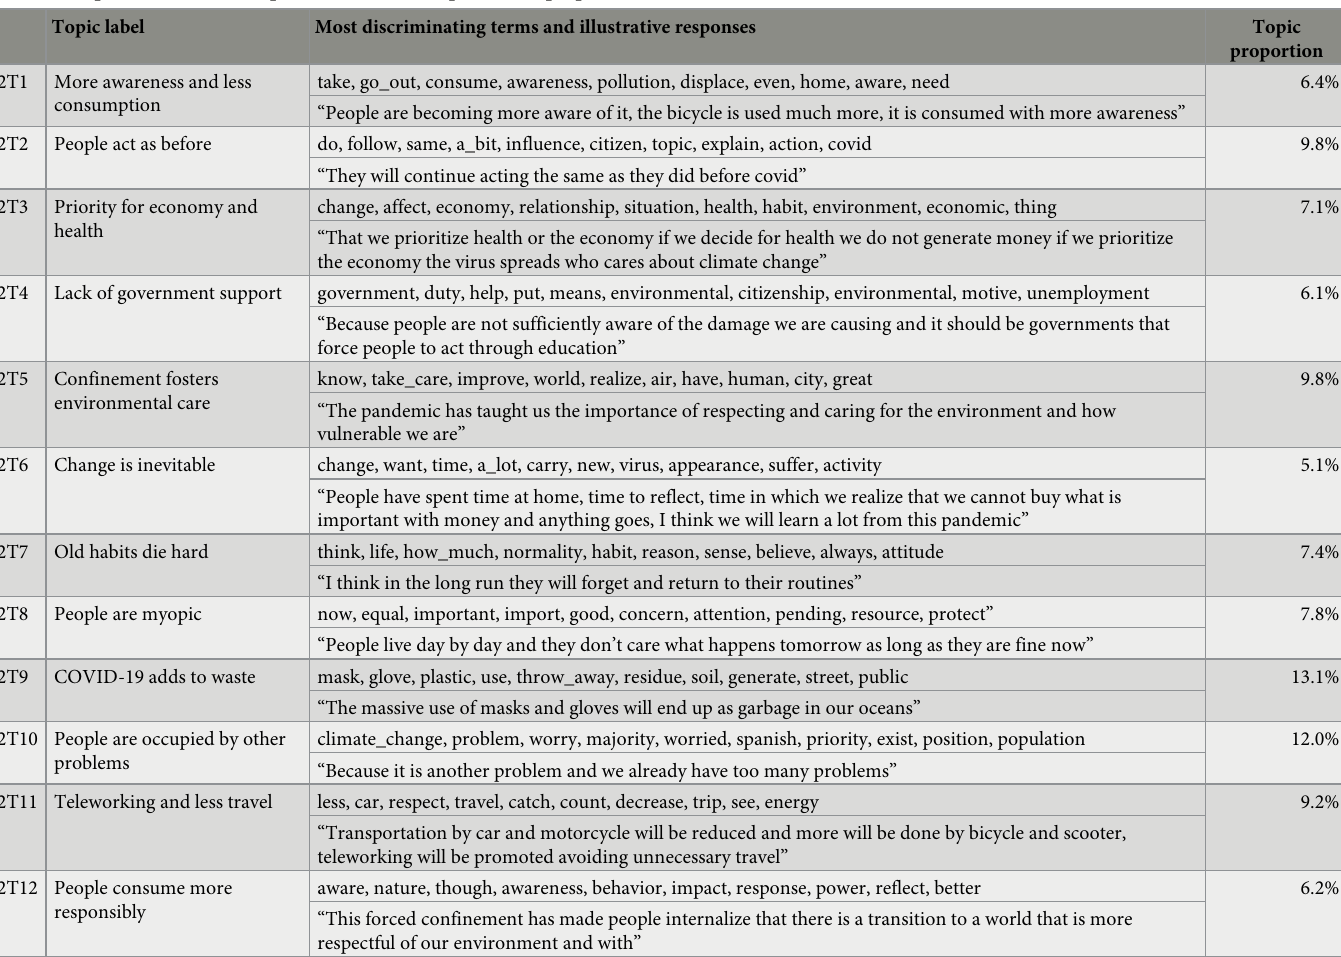
Table 2. Topics identified for responses to the second question on people’s climate action. Topic